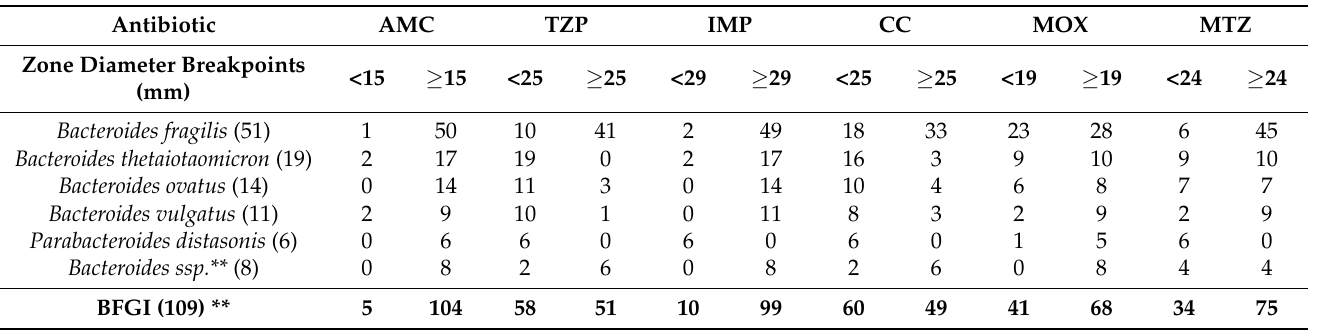
Table 2. Results of susceptibility testing by disc diffusion for the Bacteroides fragilis group isolates (BFGI), breakpoints of zone diameters according to Nagy et al., 2015 [10].